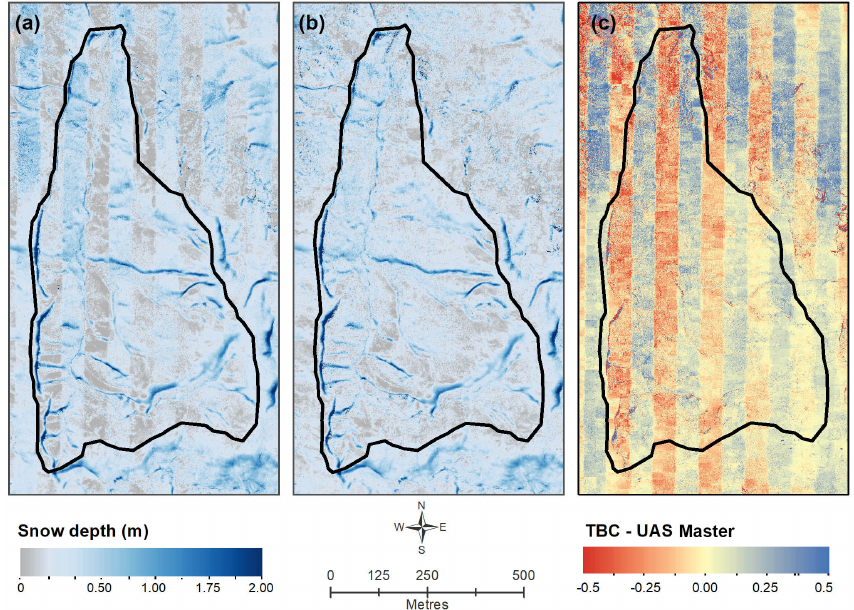
Figure 10. Map of the systematic artefacts in surface height change (dh) (expected to represent snow depth), propagated when differencing digital surface models (DSMs) resulting from aerial-triangulation in TBC v3.40 (a) compared with the dDSM from UAS Master (b) . Vertical (north–south aligned) striping is highlighted in (c) , which shows the residual between dDSMs derived from TBC and UAS Master.